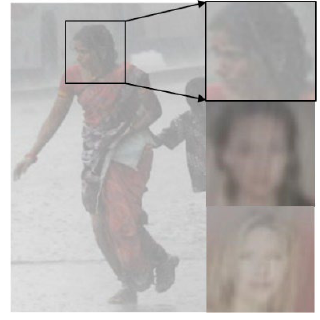
Figure 1. Example of LRHR-FIs.